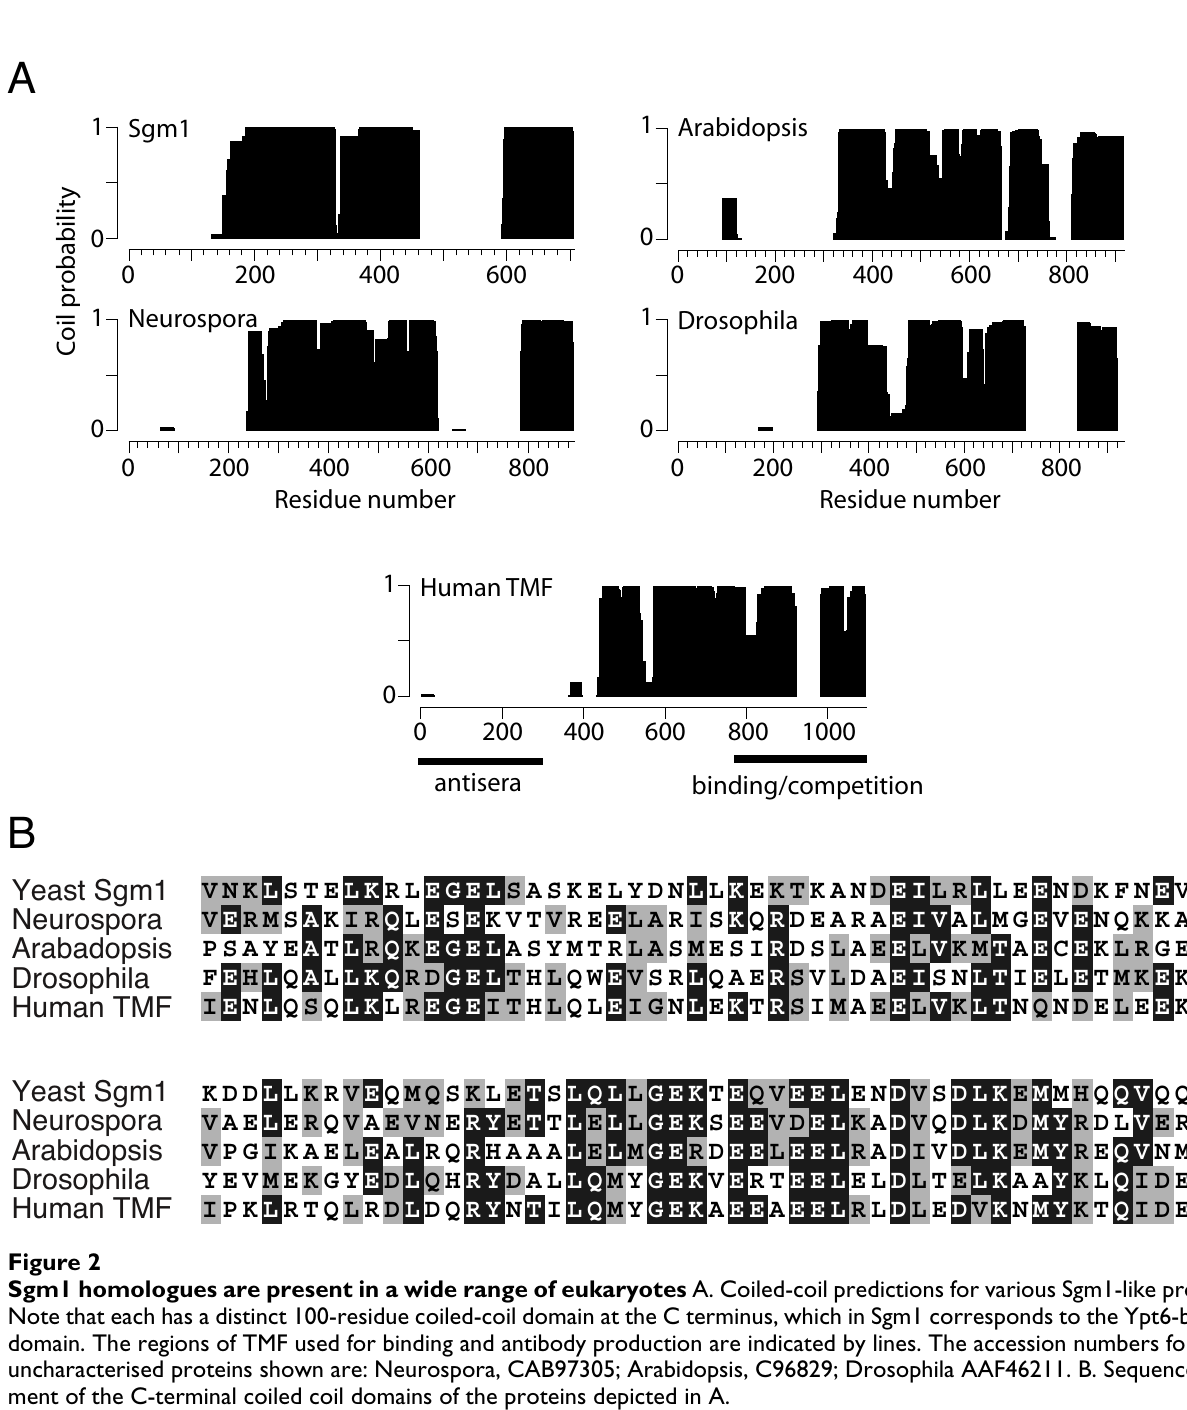
by the complete lack of binding to Rab1 or Ypt52. These results indicate that TMF is indeed a homologue of Sgm1, and shares its ability to bind a Golgi Rab protein.